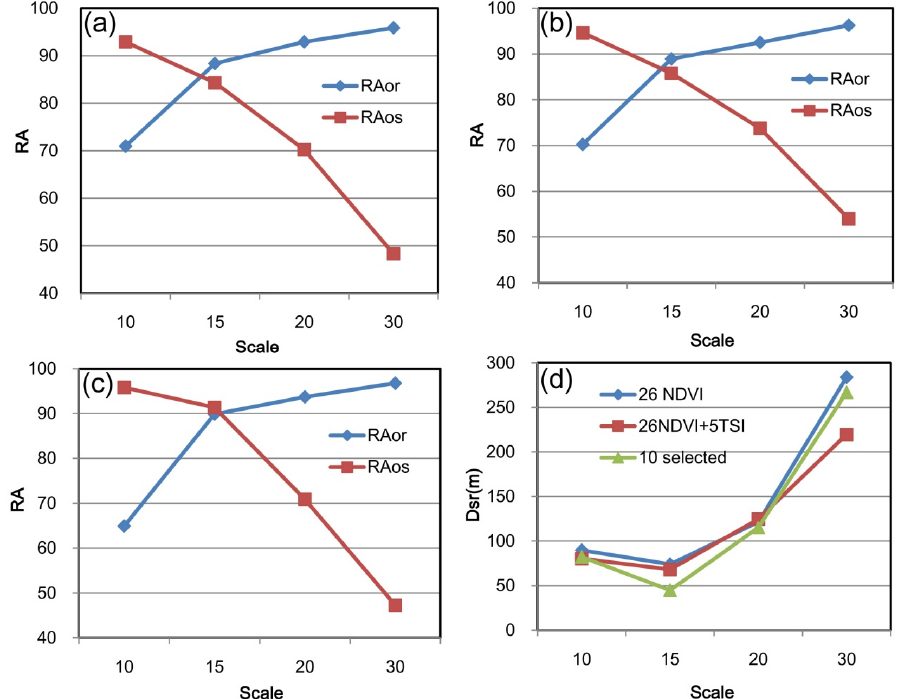
Figure 6. The segmentation quality assessment ( a ) RA of segmentation based on 26 NDVI; ( b ) RA of segmentation based on 26 NDVI + 5 NDVI TSI; ( c ) RA of segmentation based on the 10 selected features; and ( d ) the distance of centroid of segmented objects to centroid of reference objects (D sr